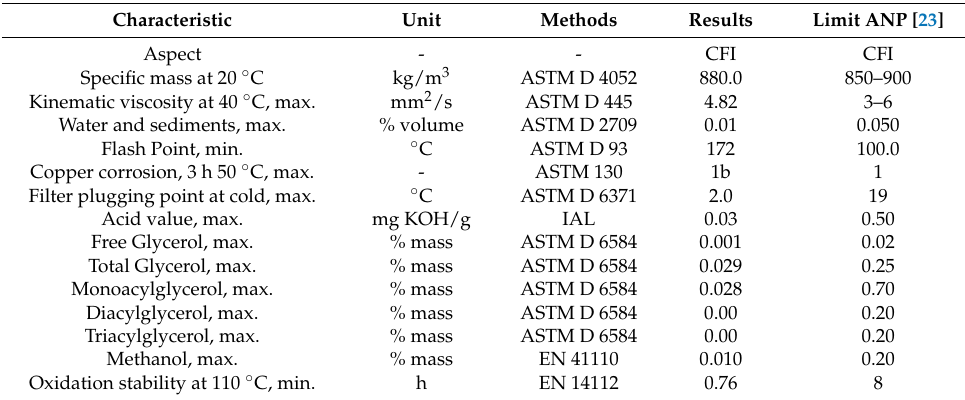
Table 2. Physico-chemical parameters of methyl biodiesel of B. glabra.